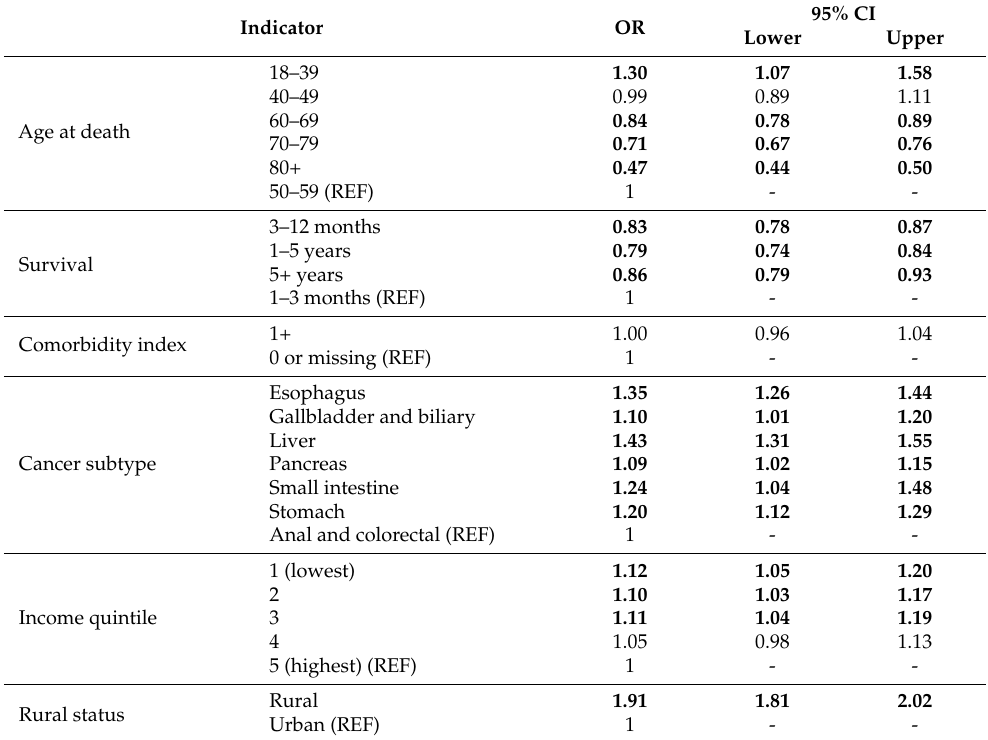
Table 4. Multivariable Logistic Regression for Aggressive Care.